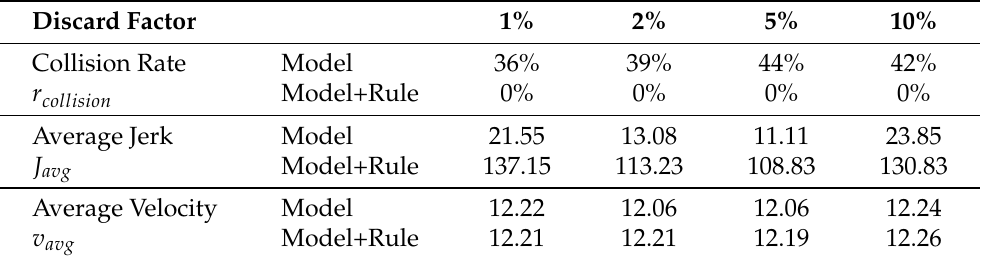
Table 3. Performance with discard